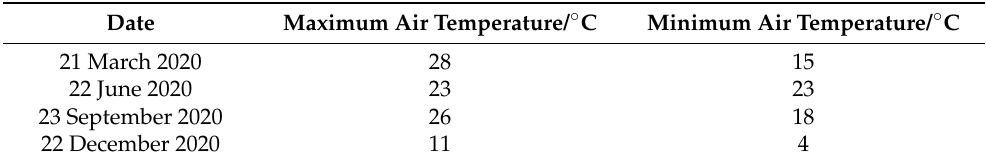
Table 2. Meteorological Parameters for Four Seasons.